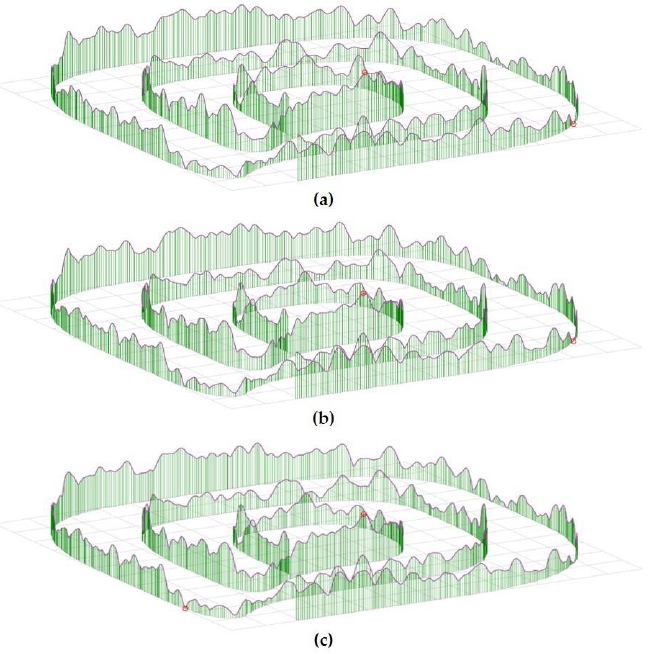
Figure 18. Plotted results for three repeated inspections for the flatness of Build3_#6_HX1_Plane1 of scale 500:1. Maximum and minimum points for each plot are highlighted with red circles. ( a ) 1st inspection: 0.062 mm; ( b ) 2nd inspection: 0.058 mm; ( c ) 3rd inspection: 0.059 mm.